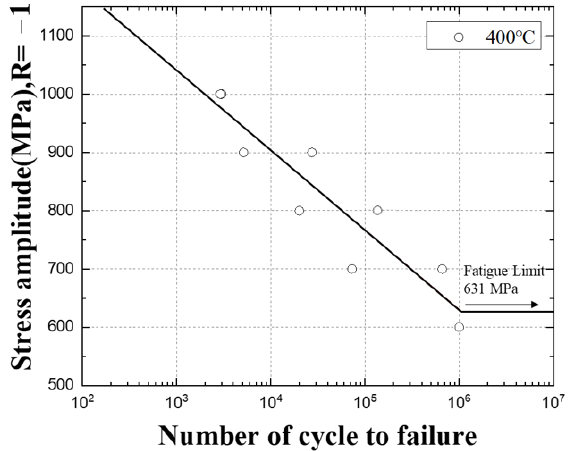
Figure 16. The S–N curve of SKD61 at 400 °C.